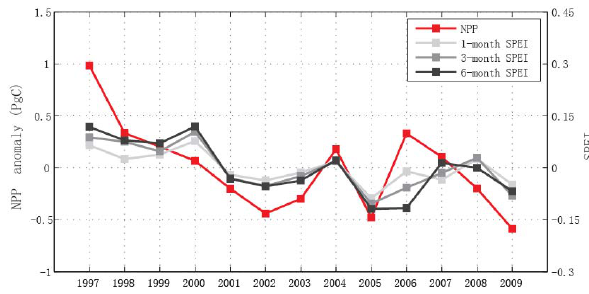
Fig. 2. Interannual variation in global NPP and SPEI anomalies dur- Figure 2. Interannual variation in global NPP and SPEI anomalies during 1997-2009. Both 528 ing 1997–2009. Both NPP and SPEI are NPP and SPEI are area-weighted 529